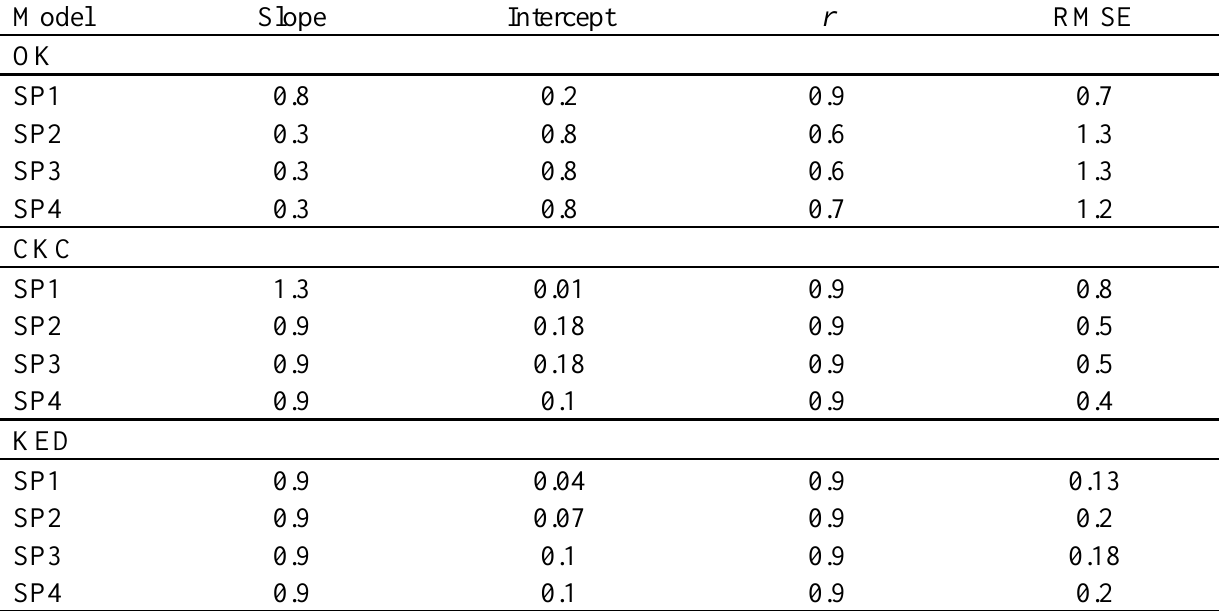
Table 5. Statistical parameters between the OK, CKC and KED predictions and the reference LAI